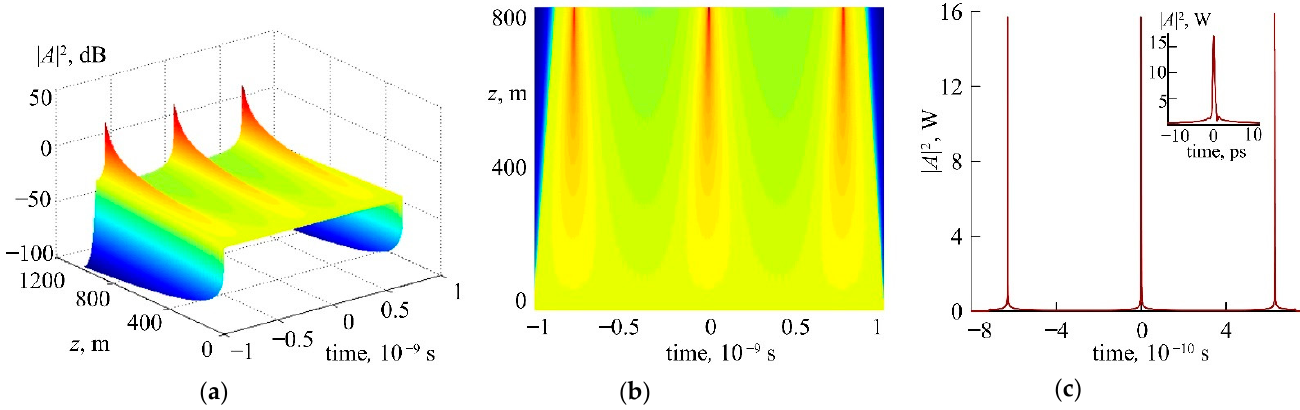
Figure 4. Pulse train formation from low-amplitude noise in cascade 2 ( a , b ). Pulse shape at the cascade 2 output, inset— enlarged central pulse of train ( c